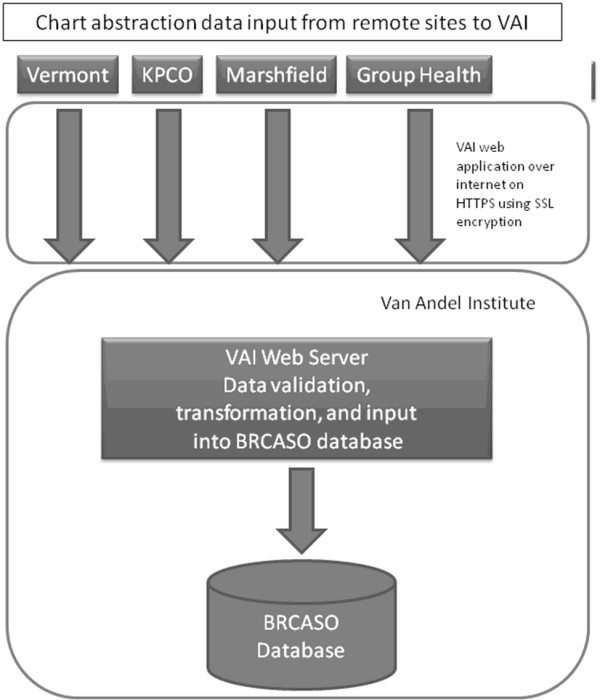
Shows how chart abstraction data were collected from each Cancer Research Network site (KPCO [Kaiser Permanente Colorado], Marshfield, and Group Health) and Vermont and entered into a secure (HTTPS) online web application hosted by VARI. Data underwent initial validation before transfer to the BRCASO database.